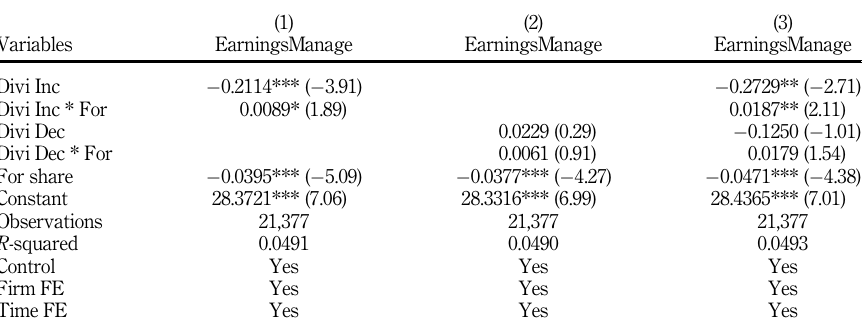
Table 6. Regression with interaction terms using